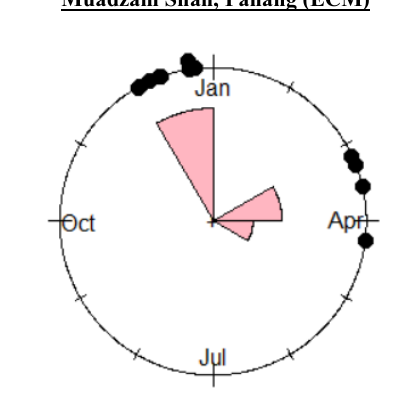
Fig. 3. Circular plots for these two